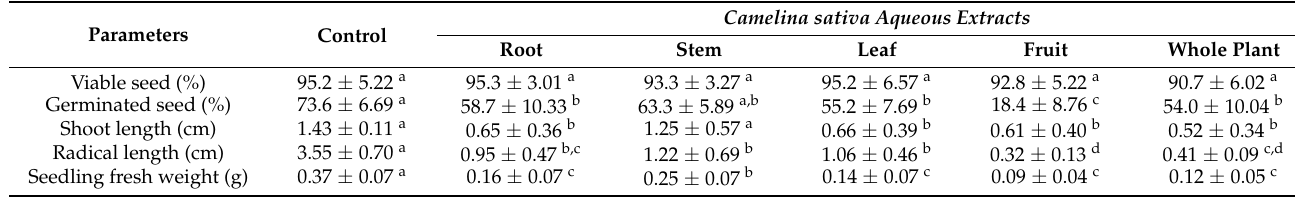
Table 4. Effect of aqueous extracts of individual parts of C. sativa at 0.1 g mL − 1 on A. artemisiifolia weed radicle length, coleoptile length and whole fresh seedling weight.